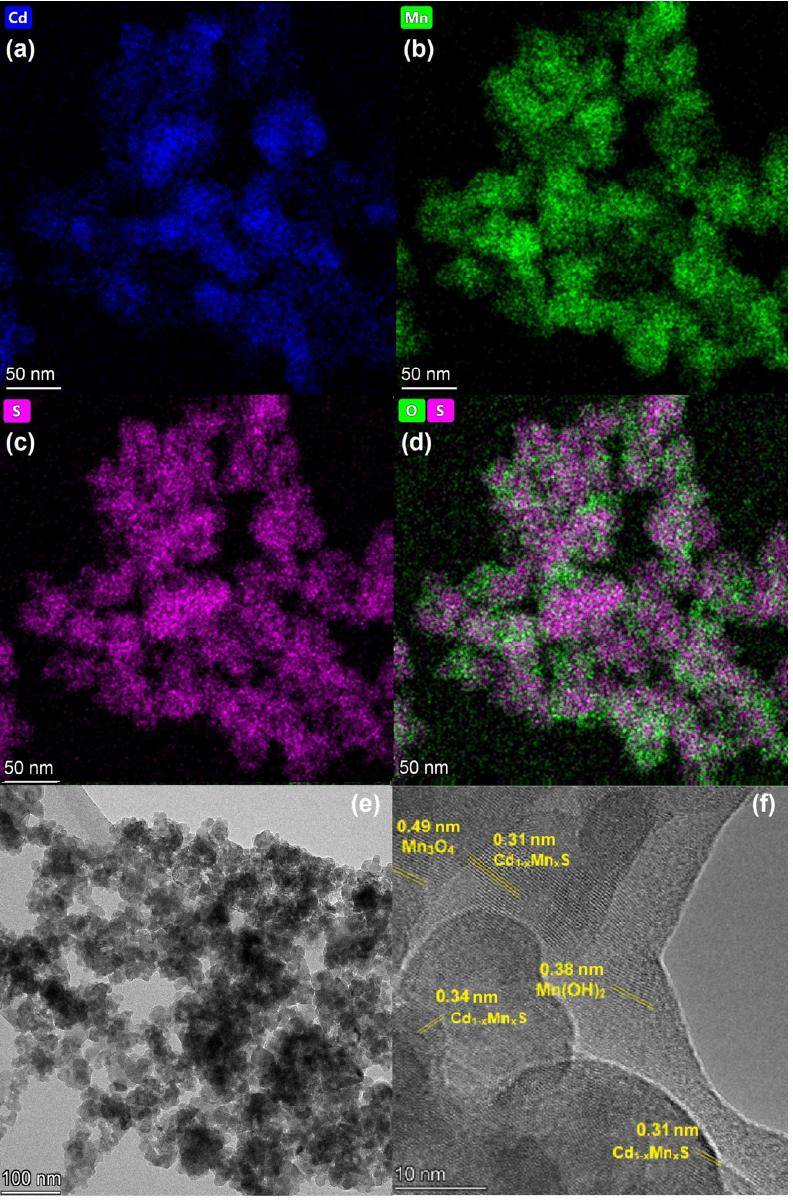
Figure 4. Element mapping ( a – d ) and TEM images ( e , f ) of Mn0.8 HT140 photocatalyst. The HRTEM images of 0.1% NiS/Mn0.6 HT120 are represented in Figure 5 and